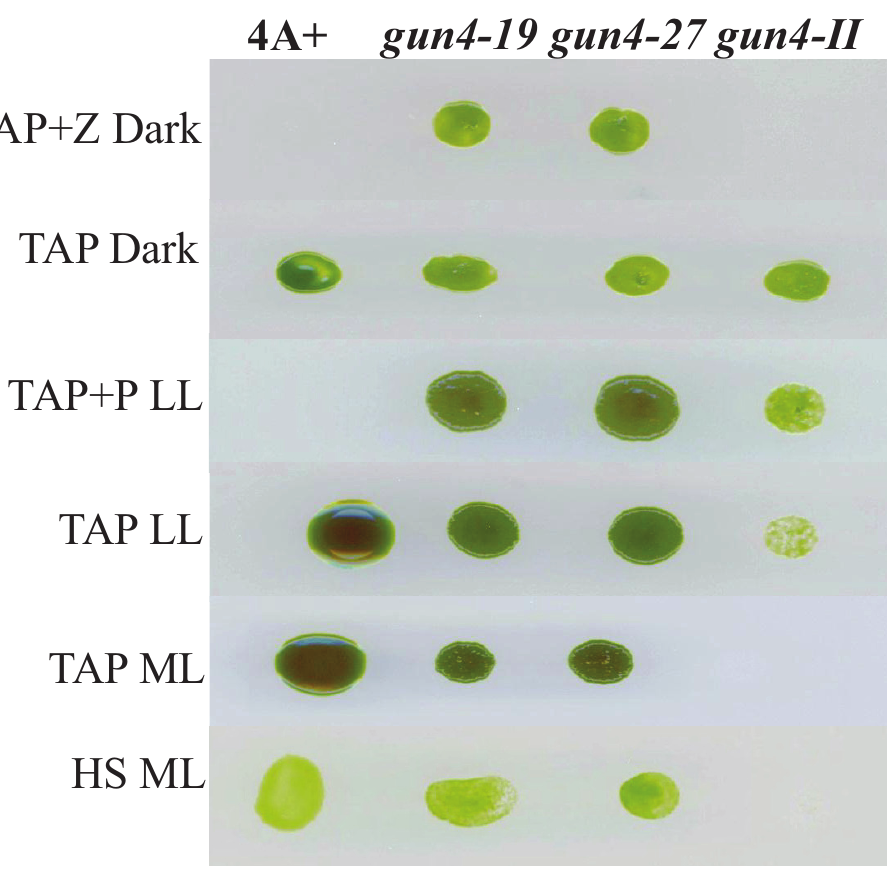
Figure 9. Growth phenotype analysis of gun4-II complements. gun4-19 and gun4-27 complements, gun4-II and 4A+ were grown for a week under six different growth conditions: TAP + Z (zeocin) in the dark, TAP in the dark, TAP + P (paromomycin) low light (LL; 50 µmol photons m -2 s -1 ), TAP LL, TAP medium light (ML; 300 µmol photons m -2 s -1 ) and HS ML.